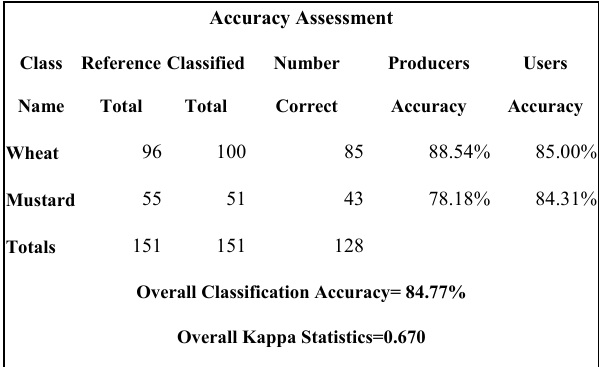
Table 6. Accuracy assessment for wheat crop